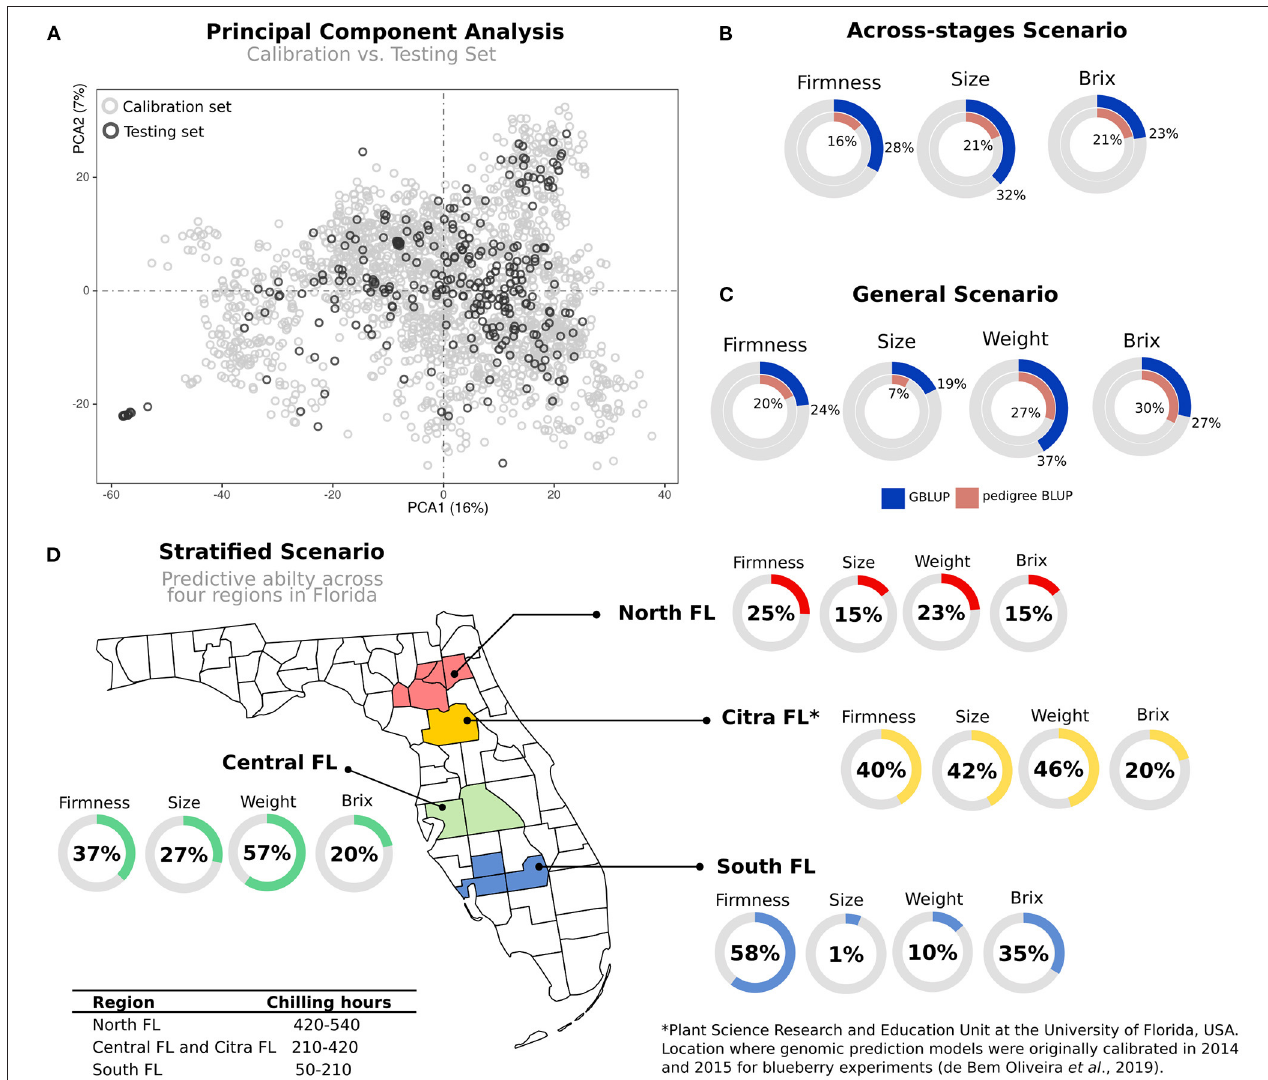
FIGURE 4 | Genomic prediction on independent validation scenarios. (A) Principal component analysis (PCA) of two blueberry populations: calibration set represents the trained set, where genomic prediction models were originally calibrated; and testing set comprising additional 280 individuals used for testing. (B) Across-stages prediction: predictive ability was measured in a subset of 114 individuals included in the calibration set, but phenotypes were collected in advanced selection stages. (C) General prediction: the predictive ability of the testing set after training the models in the calibration set. (D) Stratified predictions: after training the models in the calibration set, individuals in the testing set were predicted using phenotypes collected over four macro-regions in the Florida State, which are under different chilling hour accumulation. All predictive abilities were expressed as percentage values.